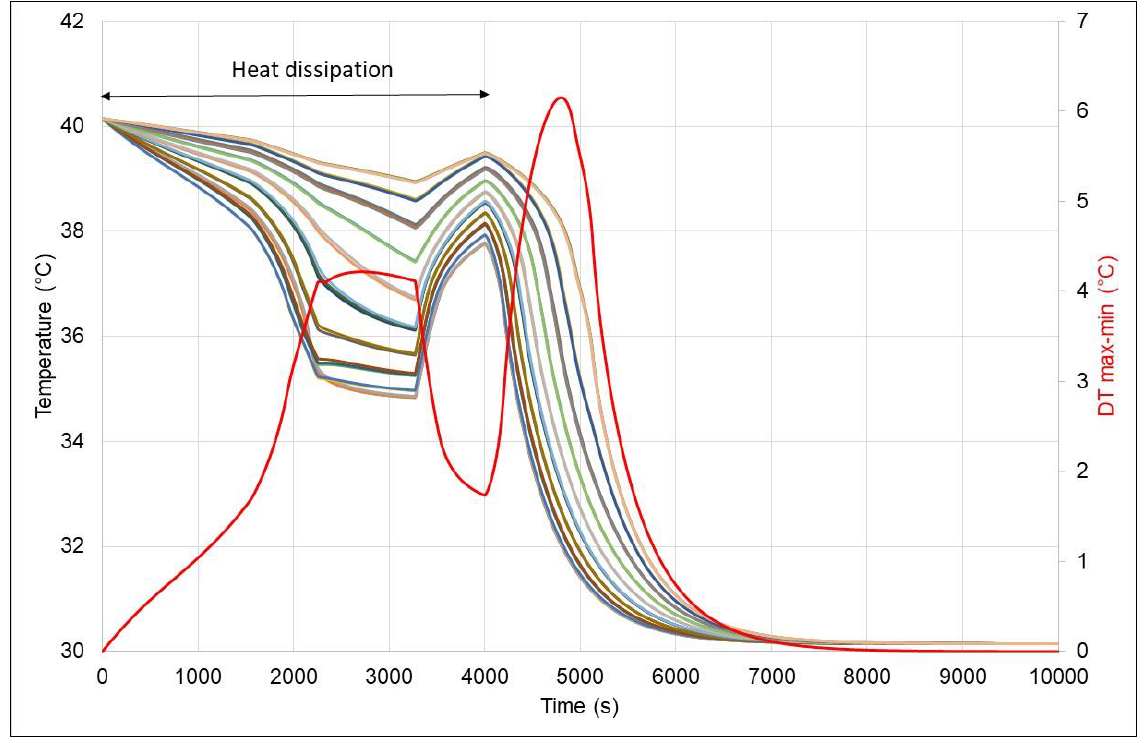
Figure 28. CFD calculations with initial temperature of the mockup equal to 40 °C and an airflow characterized by V = 2.5 m/s T = 30 °C.